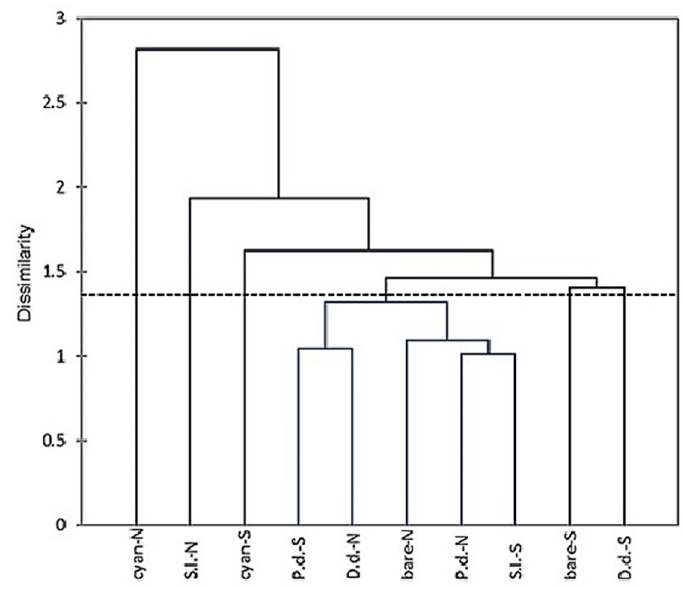
Figure 5. Clustering the microfungal communities from different crust types and bare surface at the Tabernas Desert, based on species relative abundance. Abbreviations as in Figure 3.